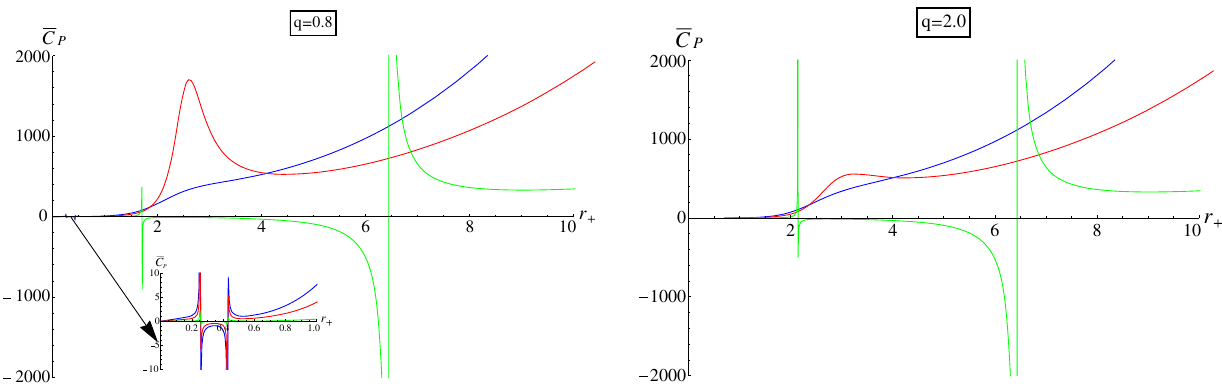
Fig. 6 Plots of the reduced heat capacity ¯ C P = 4 P = 3 , 1 , 3 , and are scaled by 1 100 π 48 π 400 π